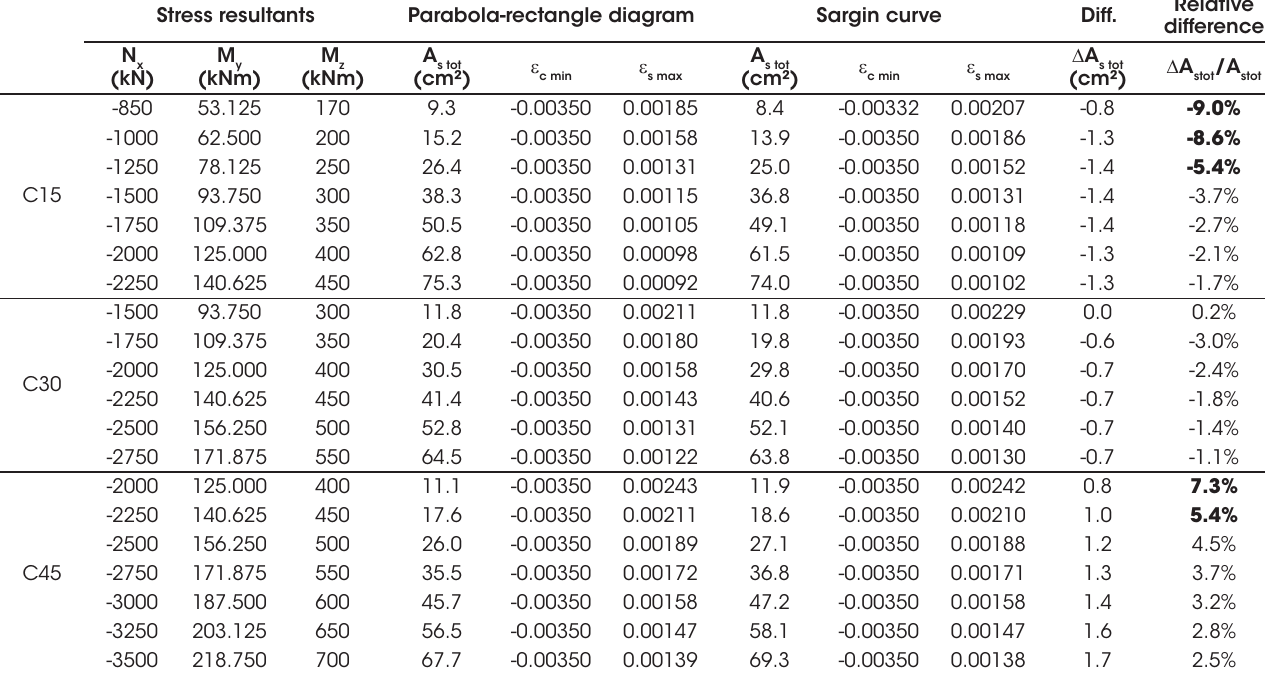
= b ⁄4 and e = b ⁄4) y y z z